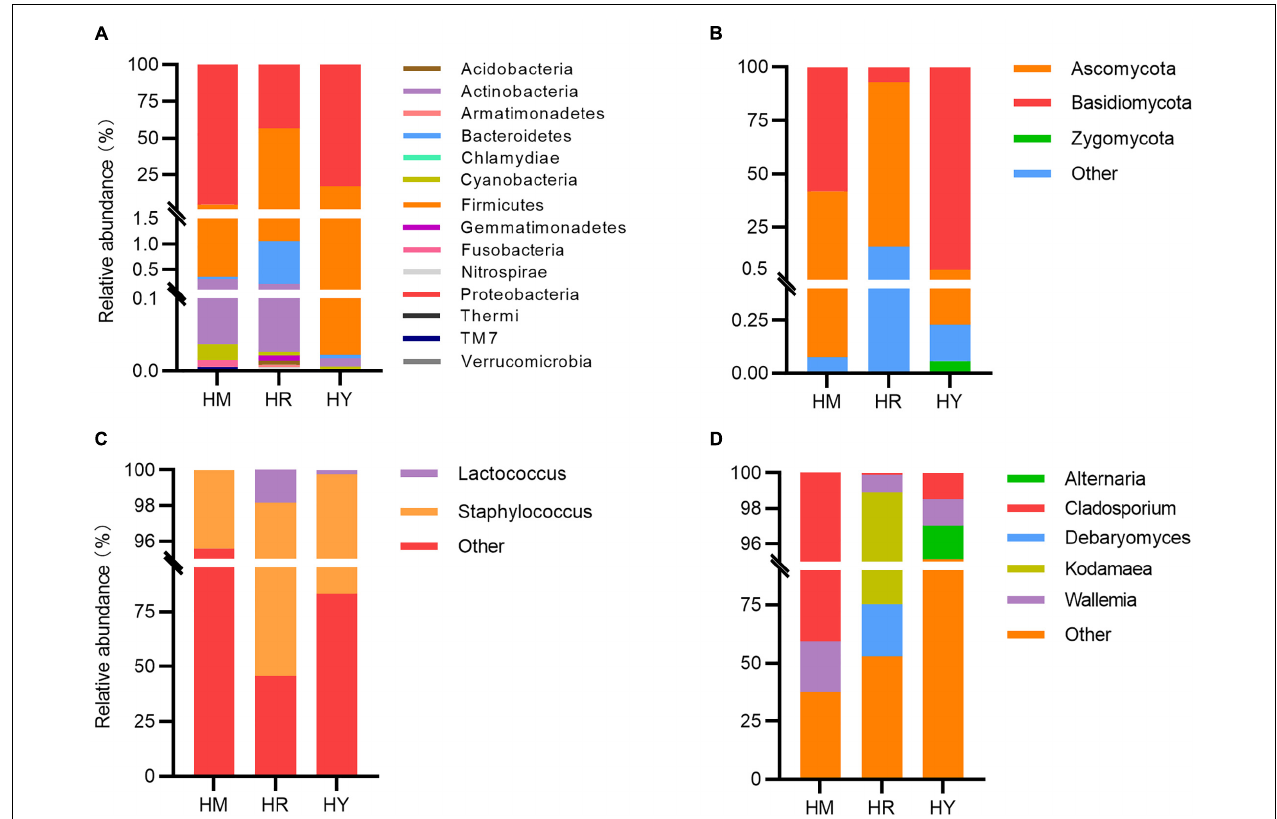
FIGURE 3 | Relative abundance of the most abundant taxa at the family or genus levels in the guts of H. axyridis fed with different diets. Bacterial taxonomic compositions at the phylum level are shown in panel (A) and at the genus level (C) ; fungi taxonomic compositions at the phylum level are shown in panel (B) and at the genus level (D)